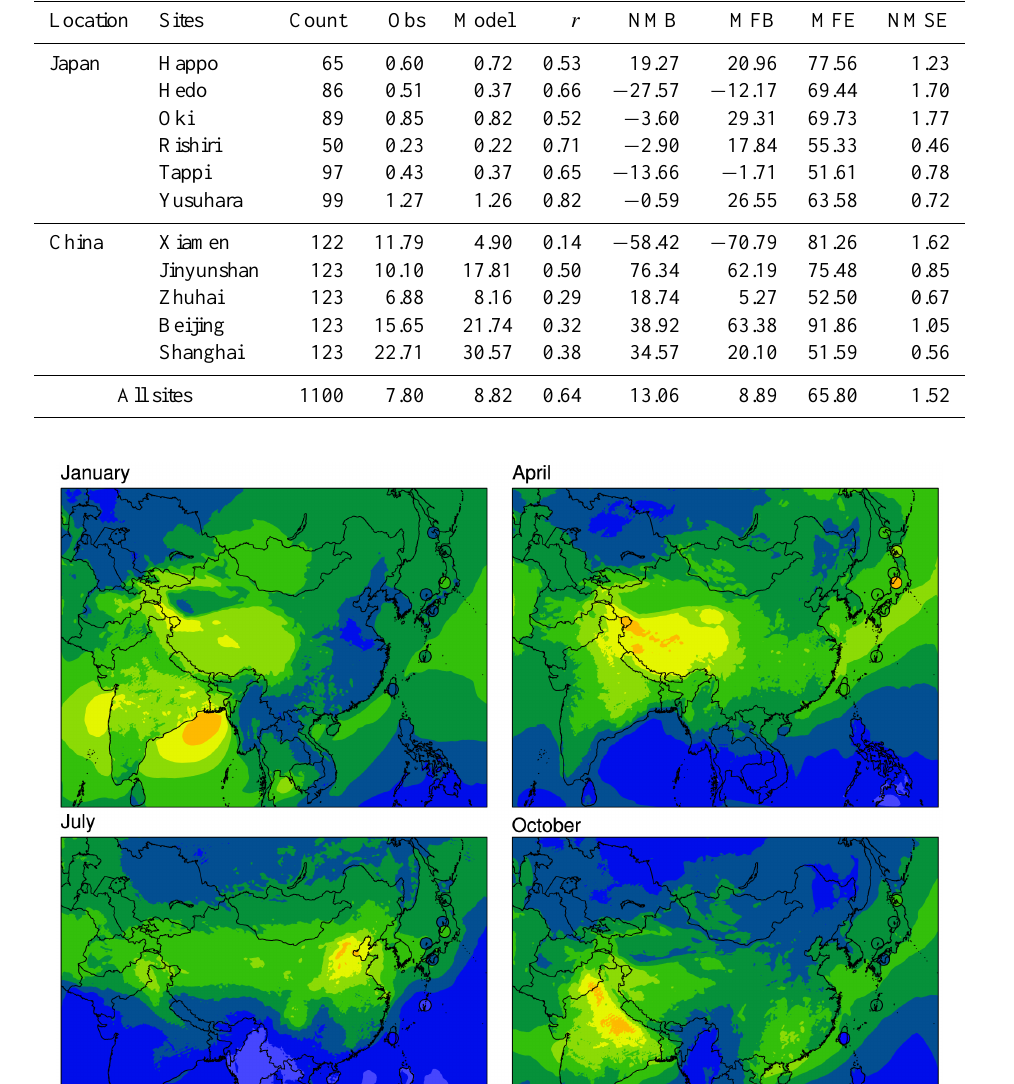
Table 5. Statistical performance of WRF-Chem–REAS simulations for SO 2 in 2007. The unit of Obs and Model is ppbv. Other statistical indicators and associated units are described in Table 2.